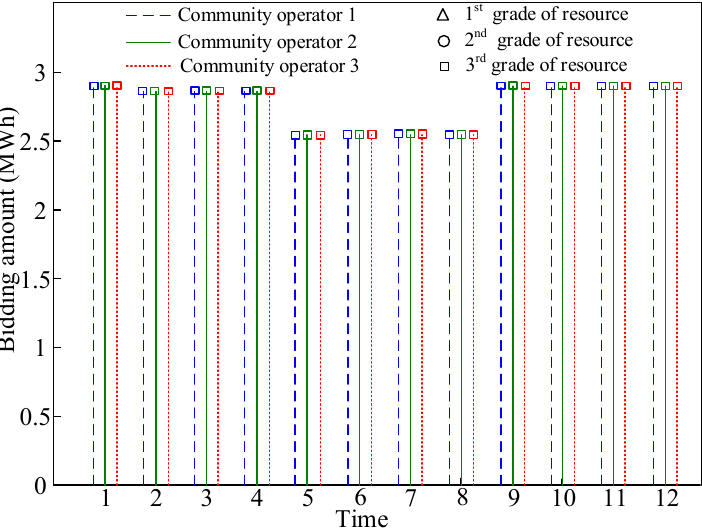
Figure 7. Bidding amount of 3 community operators in each time slot for scenario